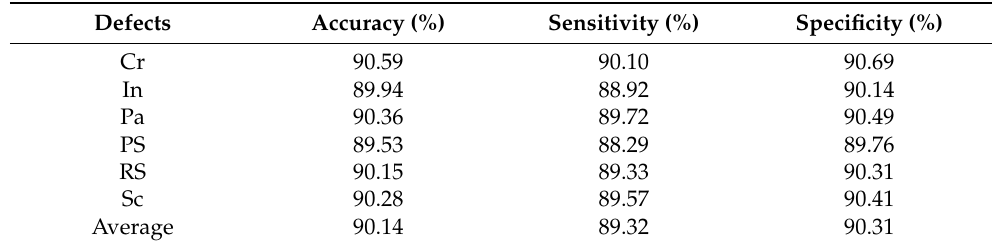
Table 4. The accuracy, sensitivity, and specificity of each defect of proposed method with the NEU dataset after data